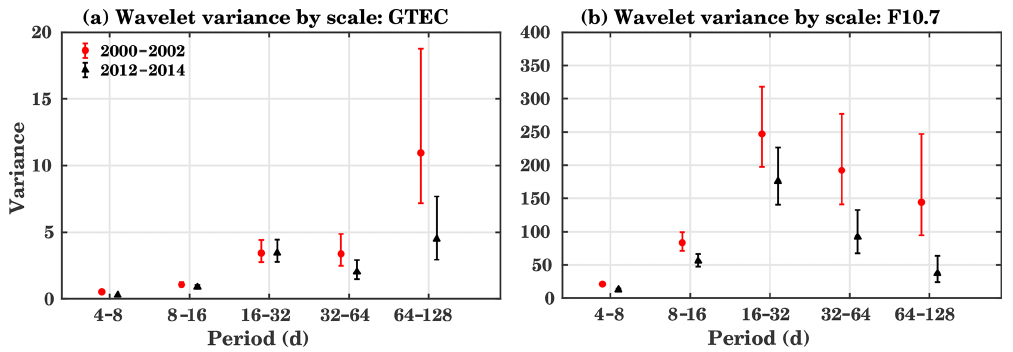
Figure 6. Wavelet variance for the maximums of SC 23 (2000–2002, red) and 24 (2012–2014, black) for (a) GTEC and (b) F10.7. Error bars show the 95% coverage probability of the confidence interval obtained from the “Chi2Eta3” confidence